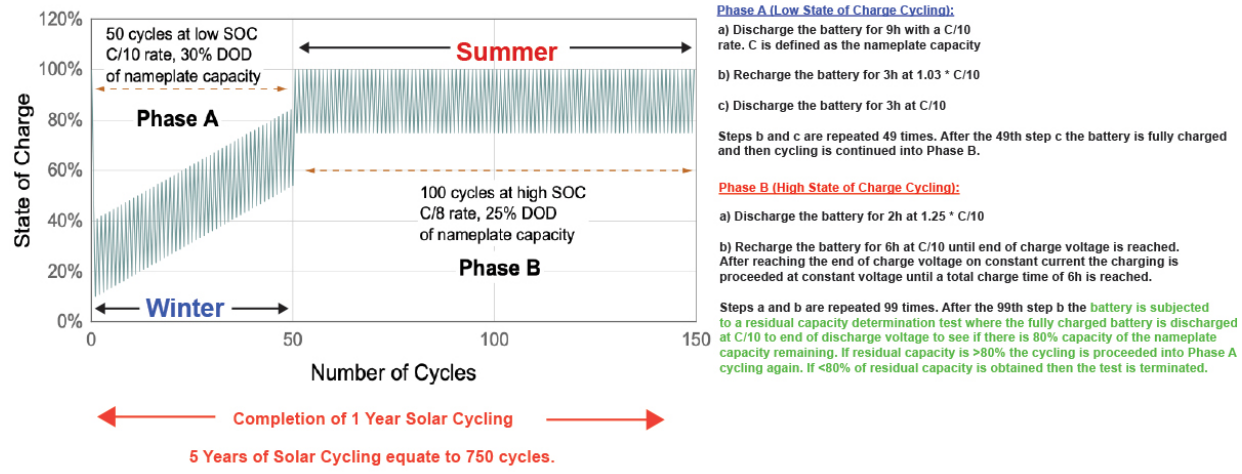
Figure 15. Schematic explanation of the IEC solar off ‐ grid protocol. The protocol is done at 40